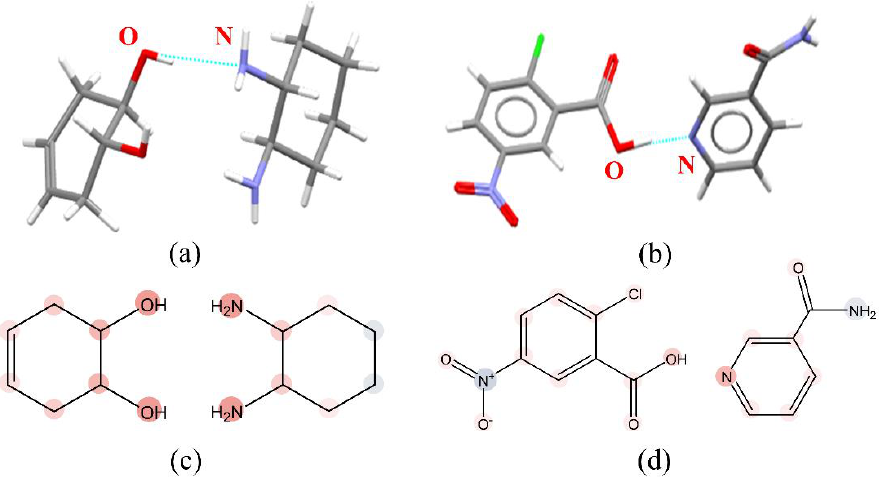
Figure 5. The 3D interaction modes and heat maps of two cocrystals: ( a ) Interaction mode diagram of cocrystal with CSD code GUCQUQ, ( b ) interaction mode diagram of cocrystal with CSD code NUBHAW. The gray, blue, red, green, and white represent carbon, nitrogen, oxygen, chlorine, and hydrogen atoms, respectively. The cyan lines represent hydrogen bonds, ( c ) Heat map for atomic contribution generated by LRP method, GUCQUQ, ( d ) Heat map for atomic contribution generated by LRP method, NUBHAW. The red, blue, and white represent positive influence, negative influence, and zero influence, respectively. Color intensity represent different contributions, the contribution increases with the darker color.